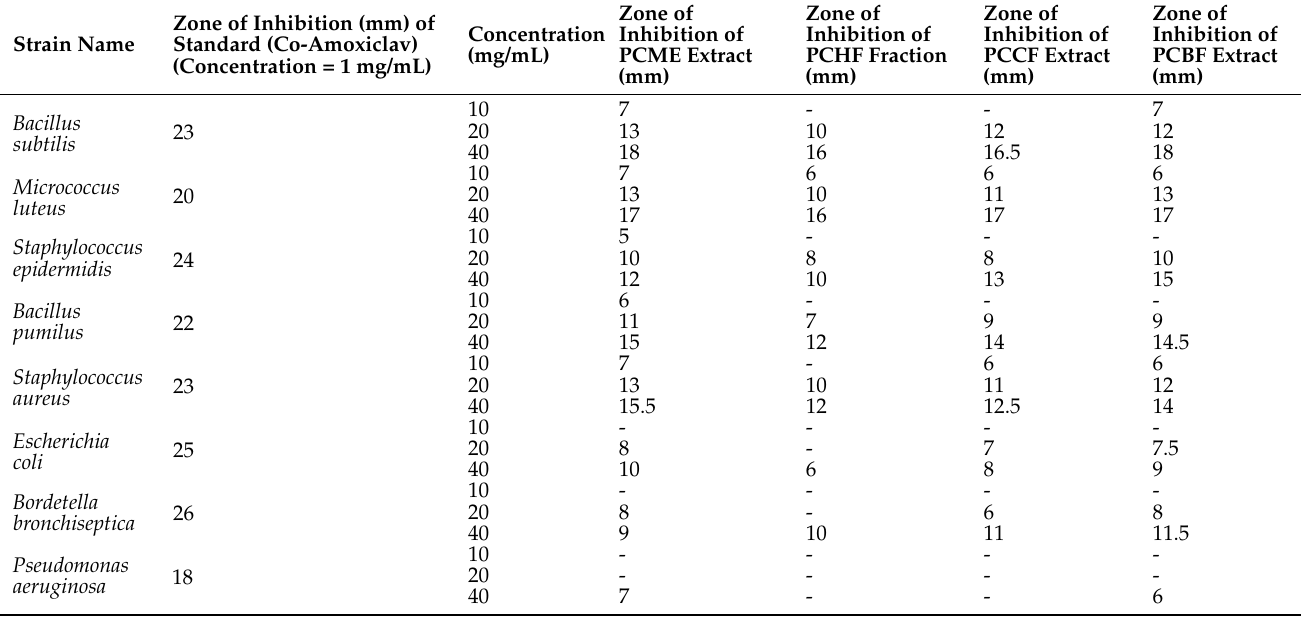
Table 7. Antibacterial activity of methanolic extract and different fractions of P. candollei